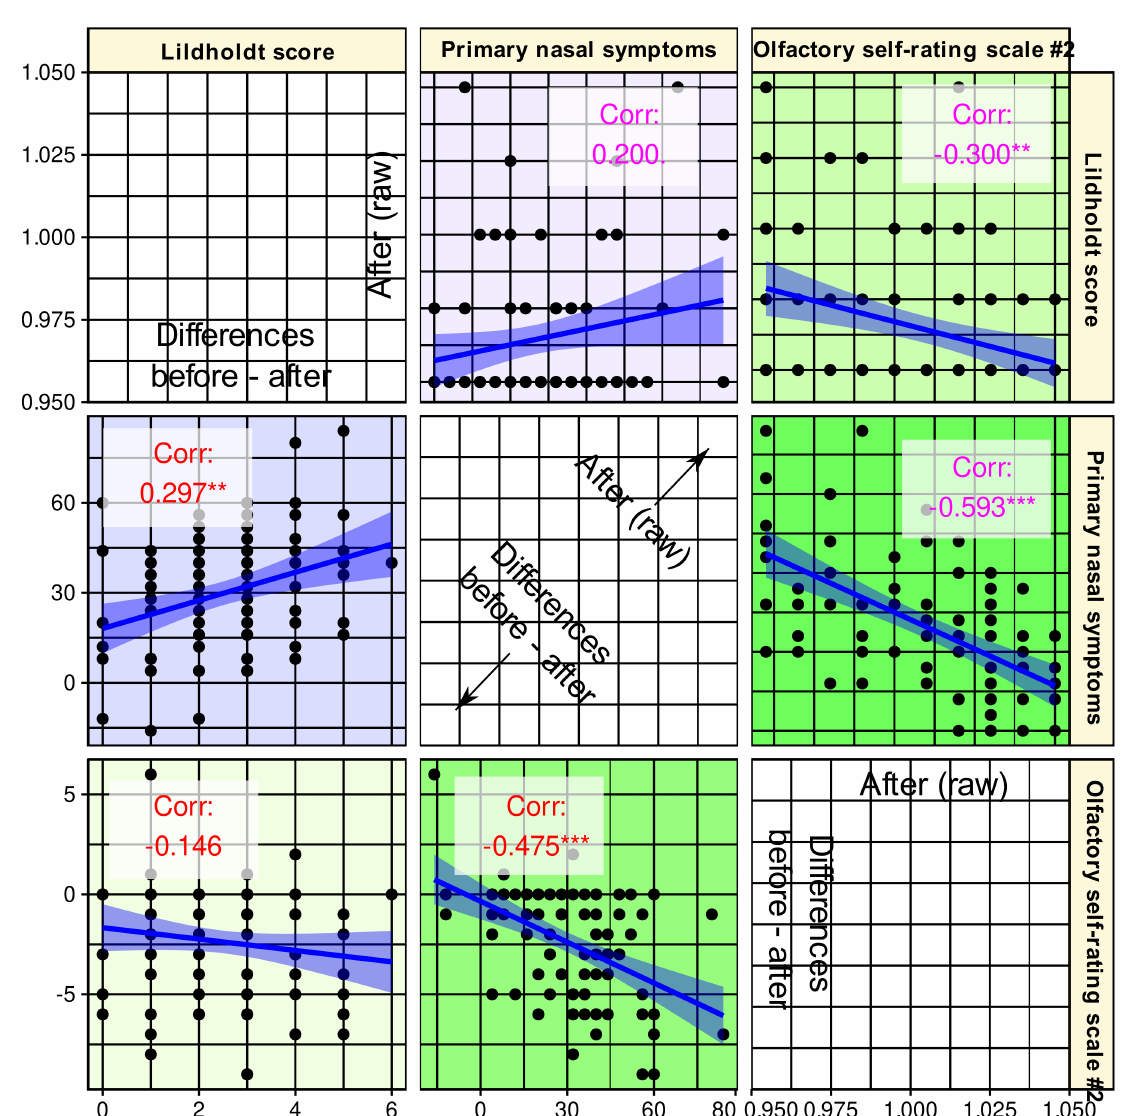
Figure 5. Correlation scatterplot matrix of the parameters selected as informative for the changes accompanying en- doscopic nasal sinus surgery. The lower triangle shows the correlation of the differences between baseline and post- surgery assessments. The upper triangle shows the correlations between raw data acquired after the surgery. The regression lines (and 95% confidence intervals) are added for visual guidance; however, statistical evaluations consisted of the calculation of non-parametric Spearman’s correlation coefficients ρ , which are provided in the panels along with indicators of statistical significance: ***: p < 0.001, **: p < 0.01, *: p < 0.05, .: p < 0.1. The figure has been created using the R software package (version 4.1 for Linux; https://CRAN.R-project.org/ (16 September 2021) [47]) and the libraries “ggplot2” (https://cran.r-project.org/package=ggplot2 (accessed on 16 September 2021) [96]) and “GGally” (https://CRAN.R-project.org/package=GGally (accessed on 16 September 2021)